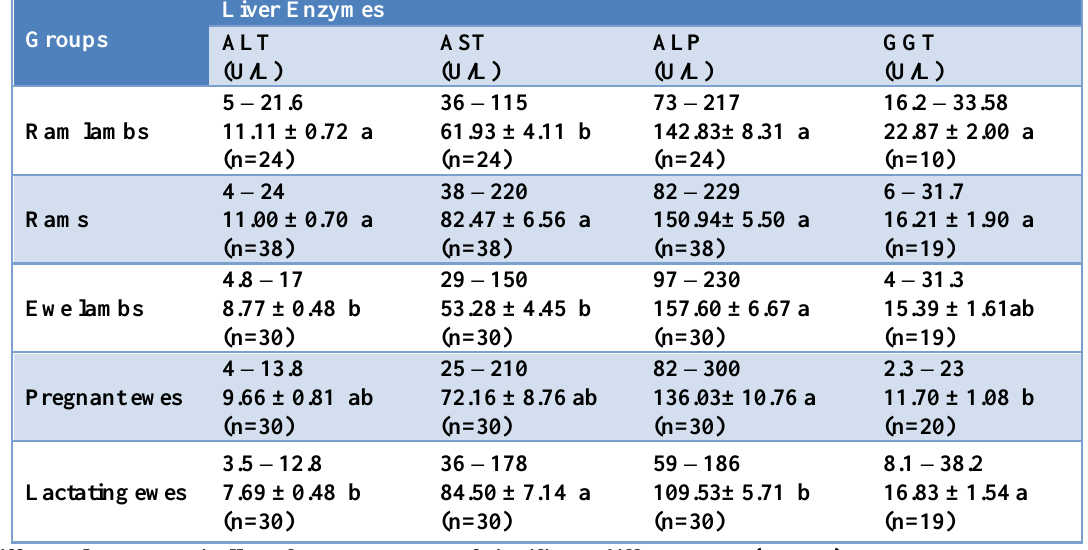
Pregnant ewes Lactating ewes Different letters vertically refers to presence of significant differences at